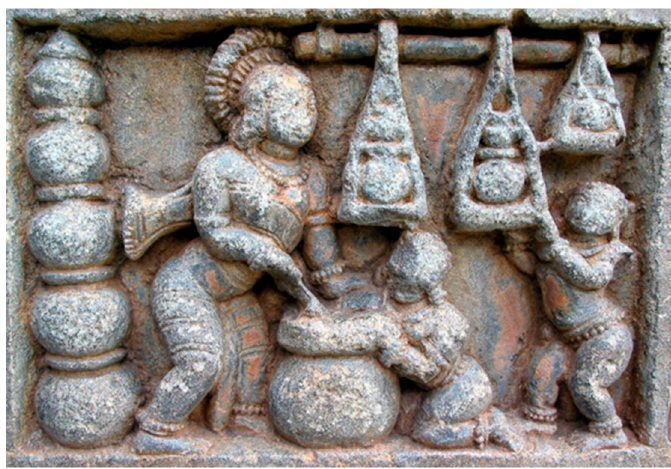
Figure 17. Two Boys Taking Butter (K ṛṣṇ a and Balar ā ma?), one in a pot on the ground, one in an u ṟ i, 13th century. Ke ś ava Temple, Somnathpur, Karnataka.